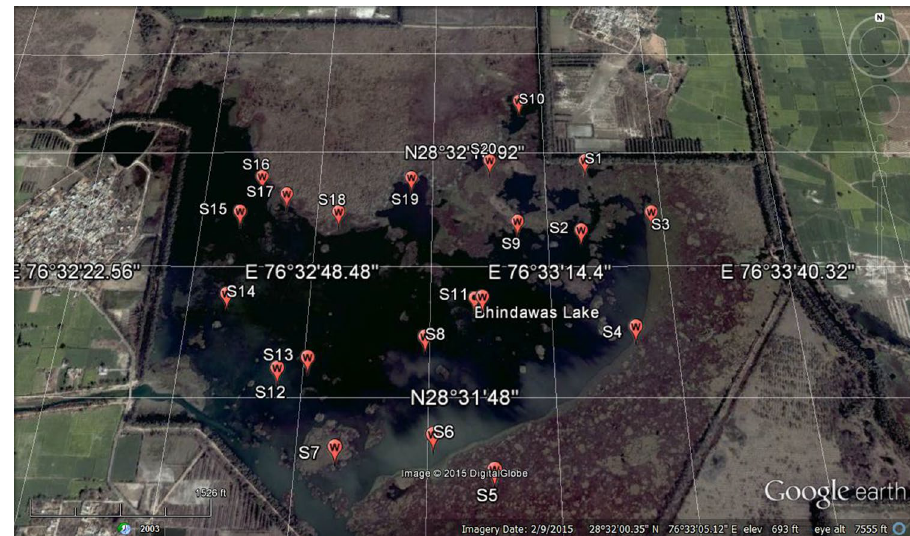
Fig. 1 Location of sampling sites in Bhindawas